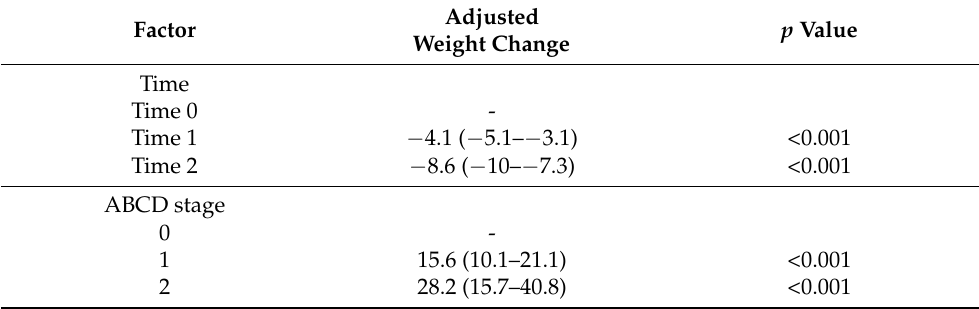
Table 5. Weight change over time fitted with a random intercept linear regression